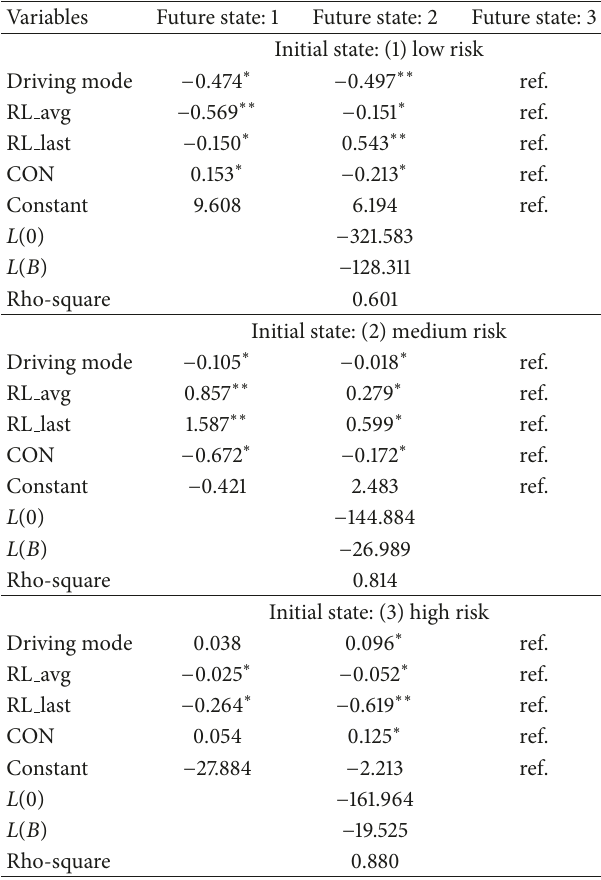
Table 6: MNL training results based on test